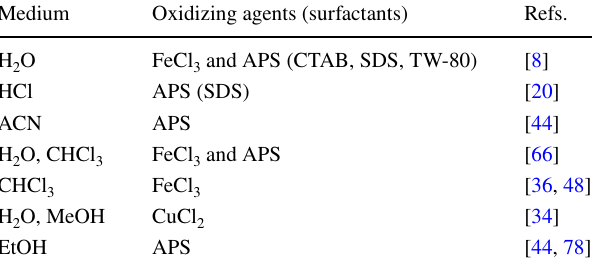
Table 1 Few reported polymerization conditions for PIN